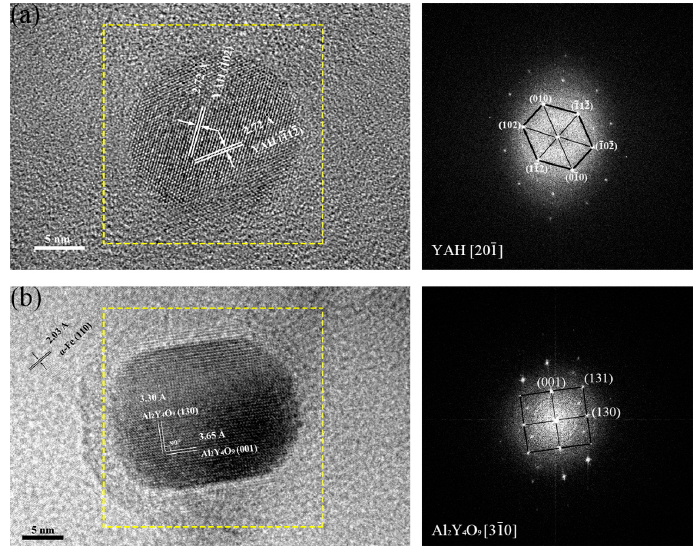
Figure 6. HRTEM micrographs and corresponding FFT images of oxide nanoparticles in 16Cr ODS steel.